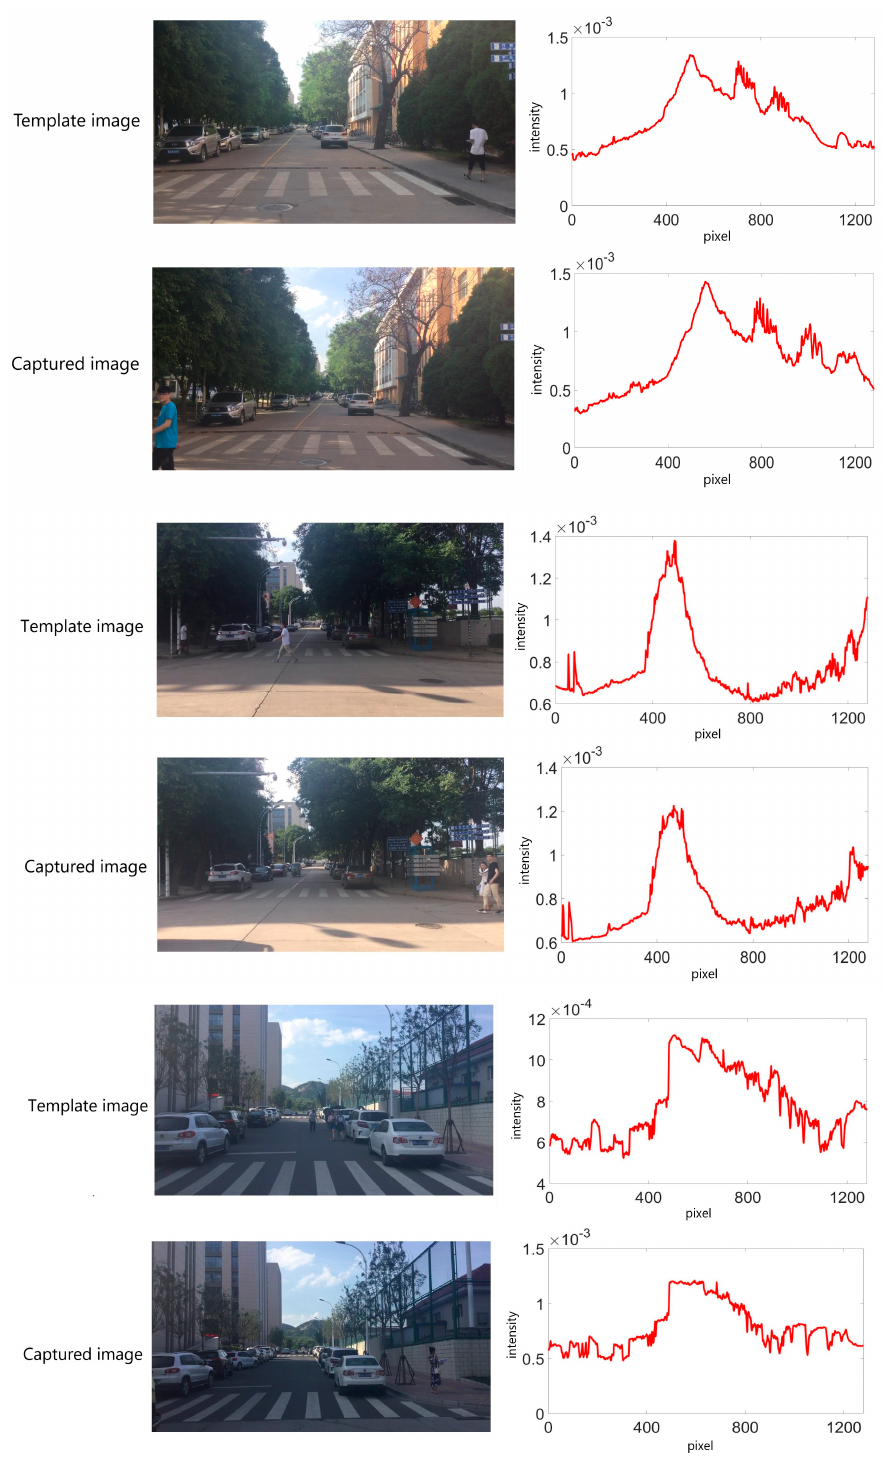
Figure 13. The captured images and their scanline profiles at the place where the three templates are captured.